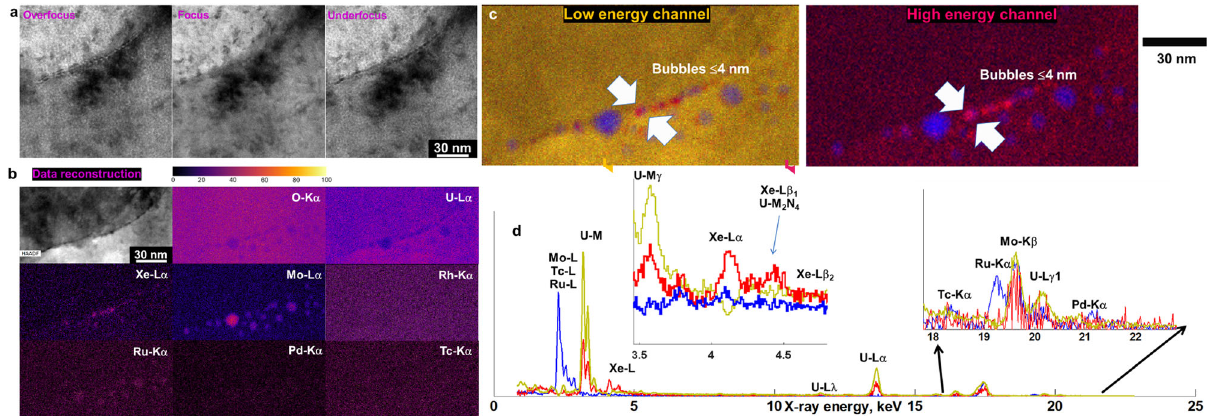
Fig. 5 Unsupervised ML improves the visibility of nanoscale Xe bubbles at the grain boundary. a Conventional TEM using Fresnel contrast method performs poorly in terms of showing fi ne features at the grain boundary. The data were acquired from the HBS of the H.B. Robinson PWR fuel rod with average burnup at ~72 MWd kgU − 1 . b ML-aided reconstruction of the STEM-EDS data shows the presence of intergranular Xe bubbles overlapping with the fi ssion-product clusters. c Combined low-/high-energy channel color mix maps reveal the fi ne-scale Xe bubbles ( ≤ 4 nm). d ML decomposition of the X-ray spectrum at the low- and high-energy ranges demysti fi es the fi ssion-product nanoclusters and Xe bubbles trapping at the grain boundary. Raw STEM-EDS map can be referred as Supplementary Fig.